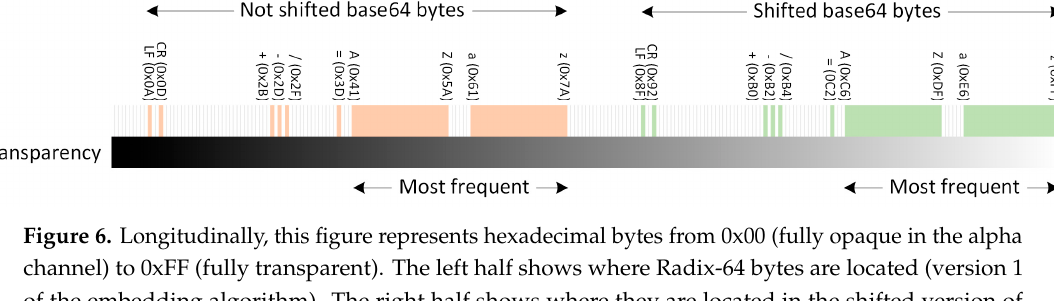
three for color information—red, green and blue—and one byte related to transparency—also referred to as alpha channel. In this implementation, two versions have been tested: